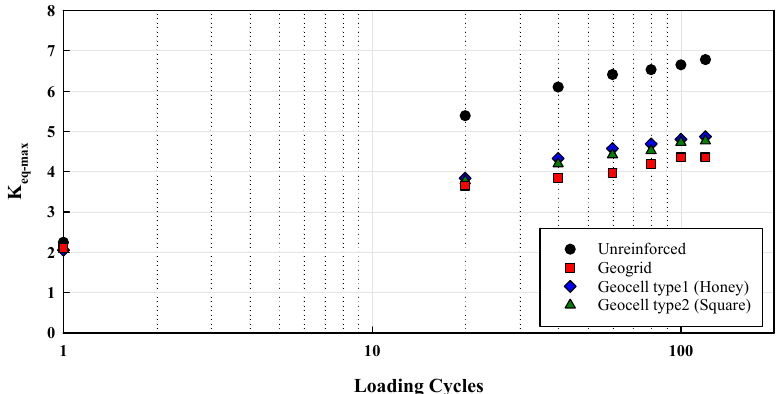
Figure 12. Variation of K eq,max with cycles during tests.